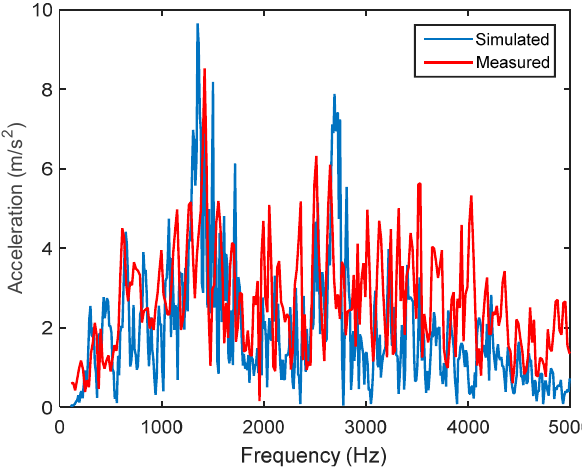
Figure 7. Comparison of simulated and measured acceleration spectra.